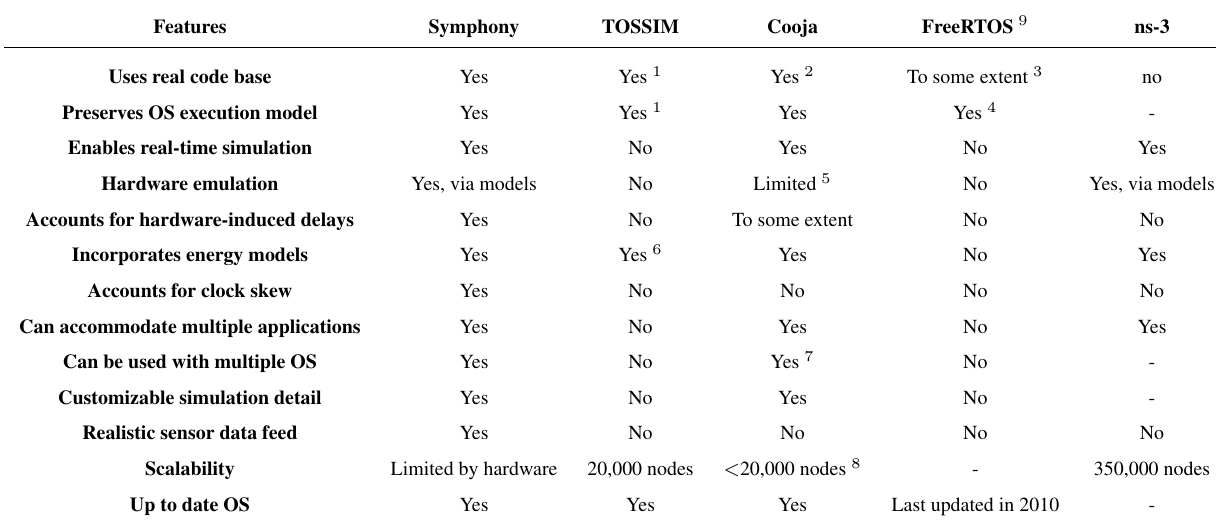
Table 1. A comparison of the functionality provided by selected network